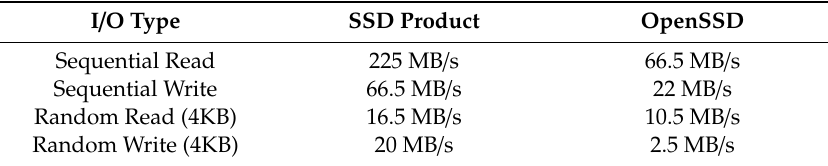
Table 4. Performance of flash storage devices.